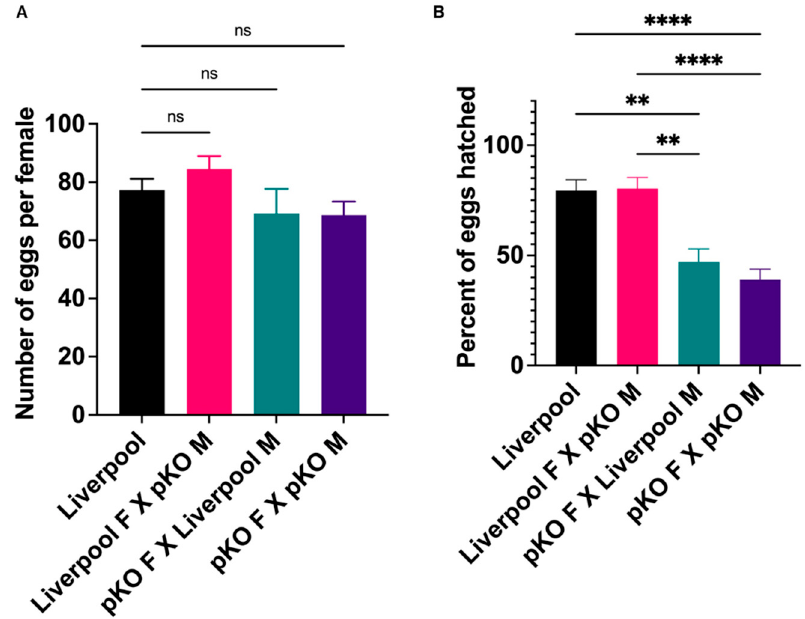
Figure 6. ( A ) Number of eggs laid per female with various crosses of the CRVP-pKO line; M = male, F = female. ( B ) Percentage of eggs hatched from various crosses of CRVP-pKO. Statistically significant p values are depicted by an asterisk (*); ** = p < 0.006, **** = p < 0.0001, error bars represent standard error of mean (Dunn’s multiple comparisons test, ns—non-significant).